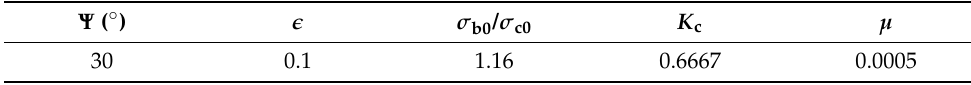
Table 6. Parameters of the concrete plastic damage